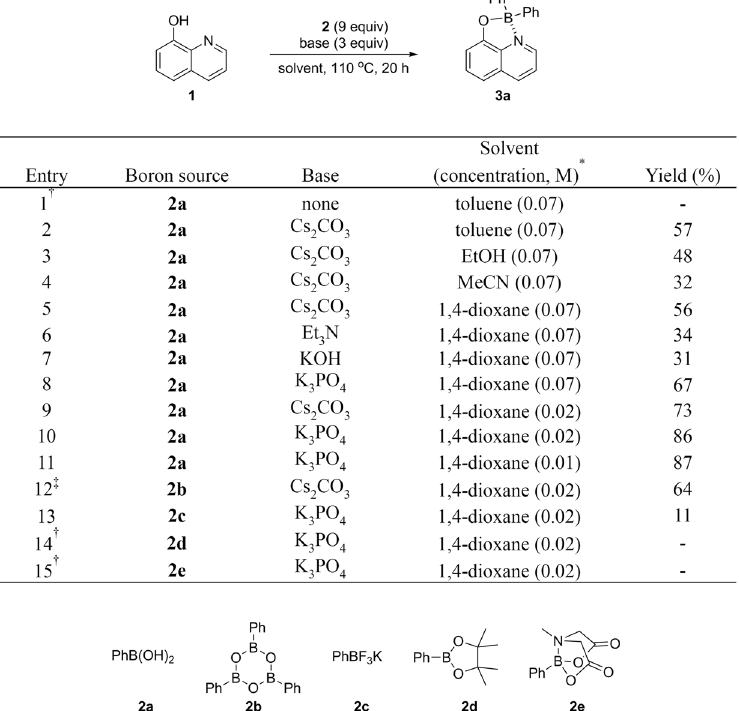
Figure 2. Optimization of reaction conditions. Conditions: 1 (1.0 mmol), 2 (9.0 equiv), base (3.0 equiv) in indicated solvent at 110 °C with stirring for 20 hours, unless otherwise stated. * Molarity based on 1 used. † No reaction observed. ‡ 3 Equiv of 2b